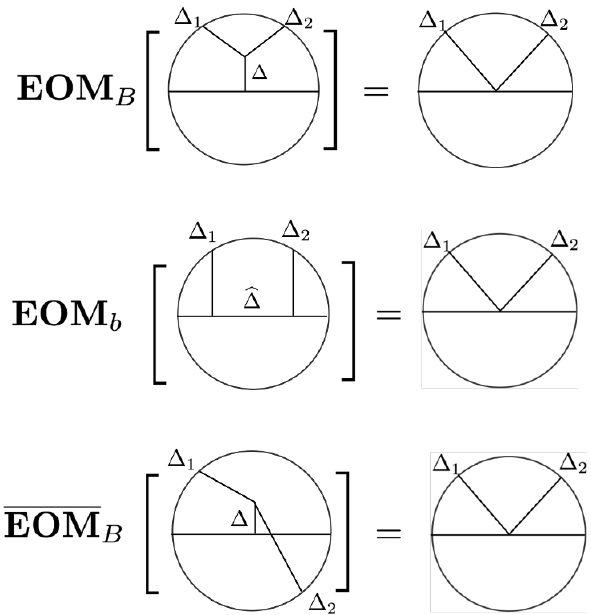
Figure 7. The equation of motion identities relating the exchange diagrams to the contact